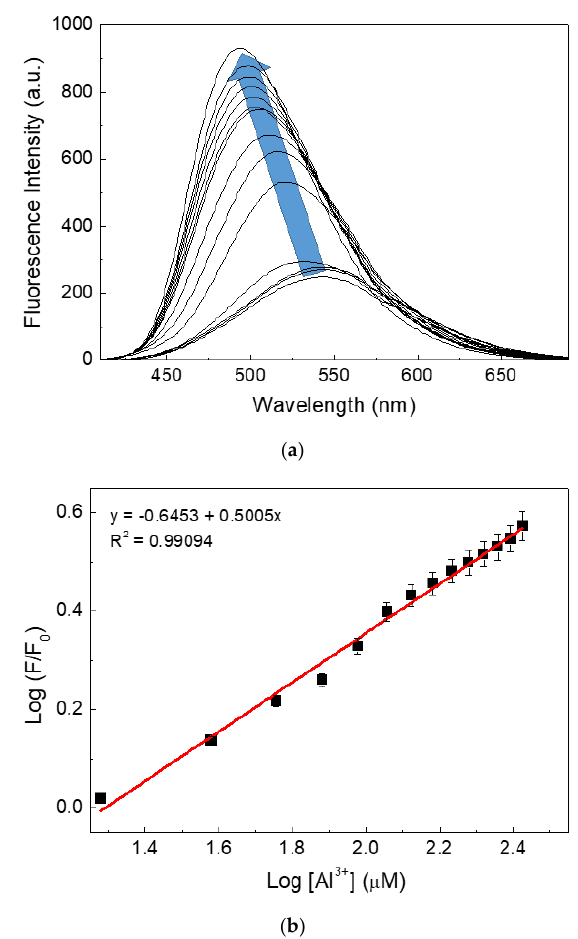
Figure 2. ( a ) Changes in the fluorescence spectra and ( b ) linear plot of DHT-K (19 µM) with various Al ion concentrations (0 to 247 µM). F 0 and F correspond to the maximum fluorescence intensity of DHT-K in the absence and presence of Al ions, respectively.